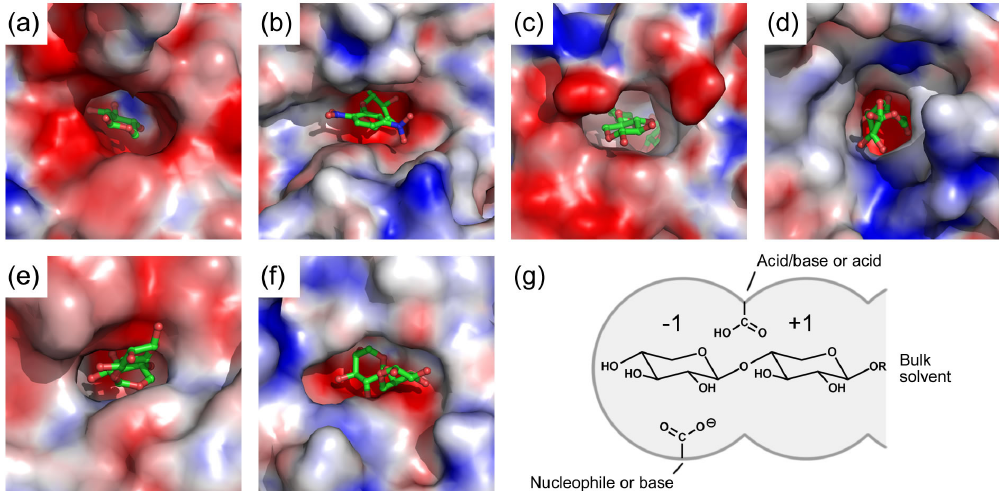
Figure 3. β -Xylosidase active site. Molecular surface drawing of active sites of β -xylosidases colored according to their electrostatic potential (negative, red; neutral, white; positive, blue). Complexed ligands are depicted in ball and stick representation with carbon atoms in green. The active sites are of ( a ) GlyA1 from metagenomic cow rumen fluid in complex with xylose (PDB 5K6N; GH3); ( b ) GsXynB1 from Geobacillus stearothermophilus T-6 in complex with 2,5-dinitrophenyl- β - d -xyloside (PDB 2BFG; GH39); ( c ) CoXyl43 from a compost metagenome in complex with xylose and xylobiose (PDB 5GLN; GH43_1); ( d ) GsXynB3 from G. stearothermophilus T-6 in complex with xylobiose (PDB 2EXJ; GH43_11); ( e ) GT2_24_00240 from Parageobacillus thermoglucosidasius TM242 in complex with xylobiose (PDB 4C1P; GH52); and ( f ) TsXylC from Thermoanaerobacterium saccharolyticum JW / SL-YS485 in complex with xylobiose (PDB 3VSU; GH120). The electrostatic potential was calculated using the APBS (Adaptive Poisson–Boltzmann Solver) implemented in the program PyMol [76]. ( g ) Generalized schematic diagram of a β -xylosidase active site with a ligand bound at subsites –1 and + 1. Catalytic residues (see below) are represented by carboxylate groups and their catalytic roles are indicated. The exact positions of the catalytic residues vary with enzymes (see Figure 6).